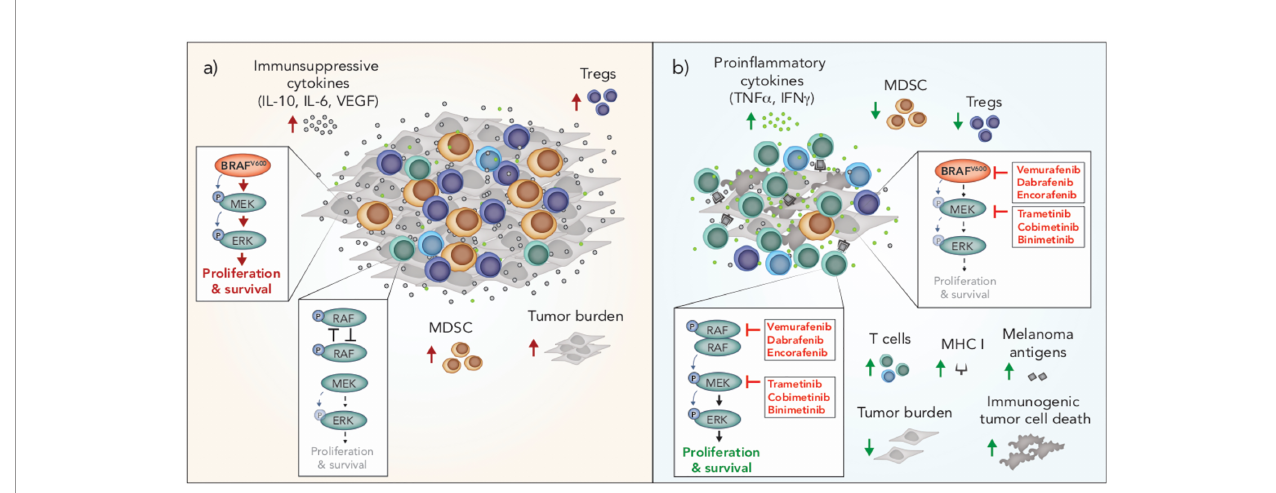
FIGURE 2 | Immunomodulation by oncogenic BRAF and inhibitors of BRAF and MEK in melanoma. (A) BRAF V600 promotes tumor progression through tumor- intrinsic activation of MAPK/ERK signaling and increased production of immunosuppressive cytokines. MAPK/ERK signaling via oncogenic BRAF V600 is associated with increased frequencies of Tregs and MDSCs in the tumor microenvironment. In T cells, RAF is not overactive and there is no aberrant MAPK/ERK signaling. (B) BRAF and MEK inhibition blocks MAPK/ERK signaling in BRAF V600 tumor cells and induces immunogenic cell death. Inhibition of MAPK/ERK promotes the upregulation of MHC I and expression of melanoma associated antigens by tumor cells and is associated with increased frequencies of T cells and pro-in fl ammatory cytokines in the tumor microenvironment. BRAF inhibition is also associated with a reduction in intratumoral immunosuppressive cells including Tregs and MDSCs. In T cells and other cells with wild type BRAF, BRAF inhibition promotes paradoxical MAPK/ERK activation through RAF dimerization and dimer-dependent enzyme transactivation, enhancing the proliferation and survival of these cells. MDSC, myeloid derived suppressor cell; Treg, Regulatory T